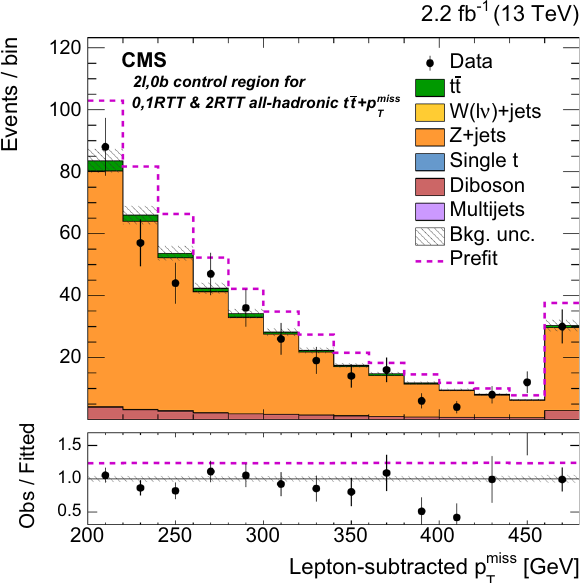
Fig. 8 Observed data, and prefit and fitted background-only, lepton- subtracted p miss distributions in the dileptonic control region (hadD in T Table2)fortheall-hadronic t t + p miss signalregions.Thiscontrolregion T is used to constrain Z (ν ¯ ν) + jets background. The selections for jets and p miss used in the 0,1 RTT signal region are applied, with those on T p miss appliedtolepton-subtracted p miss .Thesignalregionrequirements T T −→ , −→ p miss ) and b tags are removed to increase Z + jets p jet i on min (cid:7)φ( T T yields. The last bin contains overflow events. The lower panel shows the ratios of observed data to fitted background yields. In both panels, the statistical uncertainties of the data are indicated as vertical error bars and the fit uncertainties are indicated as hatched bands. Prefit yields and the ratios of prefit to fitted background expectations are shown as dashed magenta histograms 0,1 RTT SR are applied in the Z ((cid:5)(cid:5)) + jets CR, with